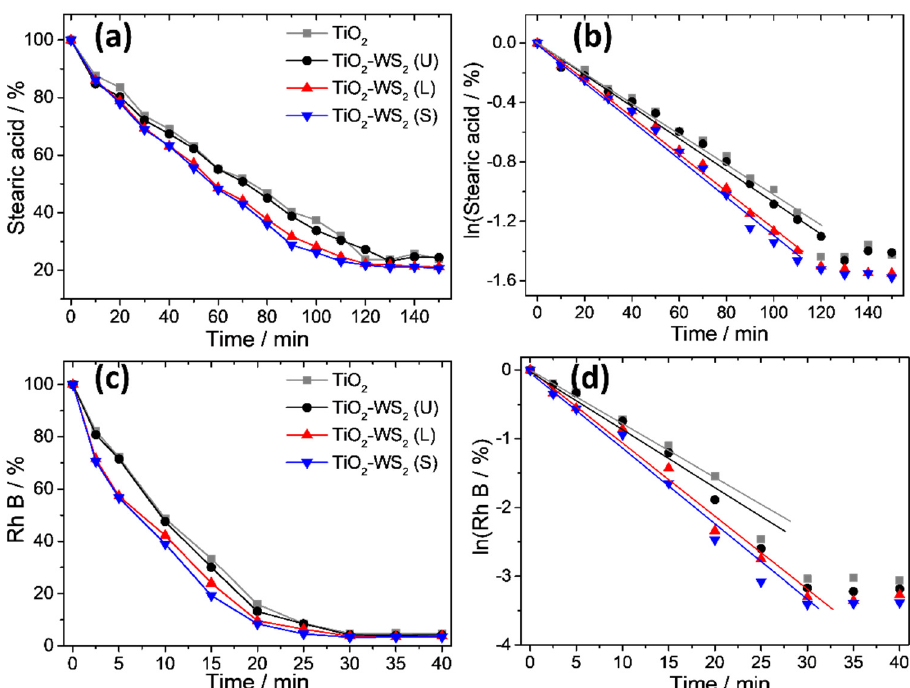
Figure 7. Photoinduced degradation of ( a ) stearic acid and ( c ) RhB on the WS 2 -TiO 2 films, and the pseudo-first-order fit of ( b ) stearic acid and ( d ) RhB decay at increasing times of UV irradiation: undoped TiO 2 (grey line), TiO 2 -WS 2 -U (black line), TiO 2 -WS 2 -L (red line), and TiO 2 -WS 2 -S (blue line).